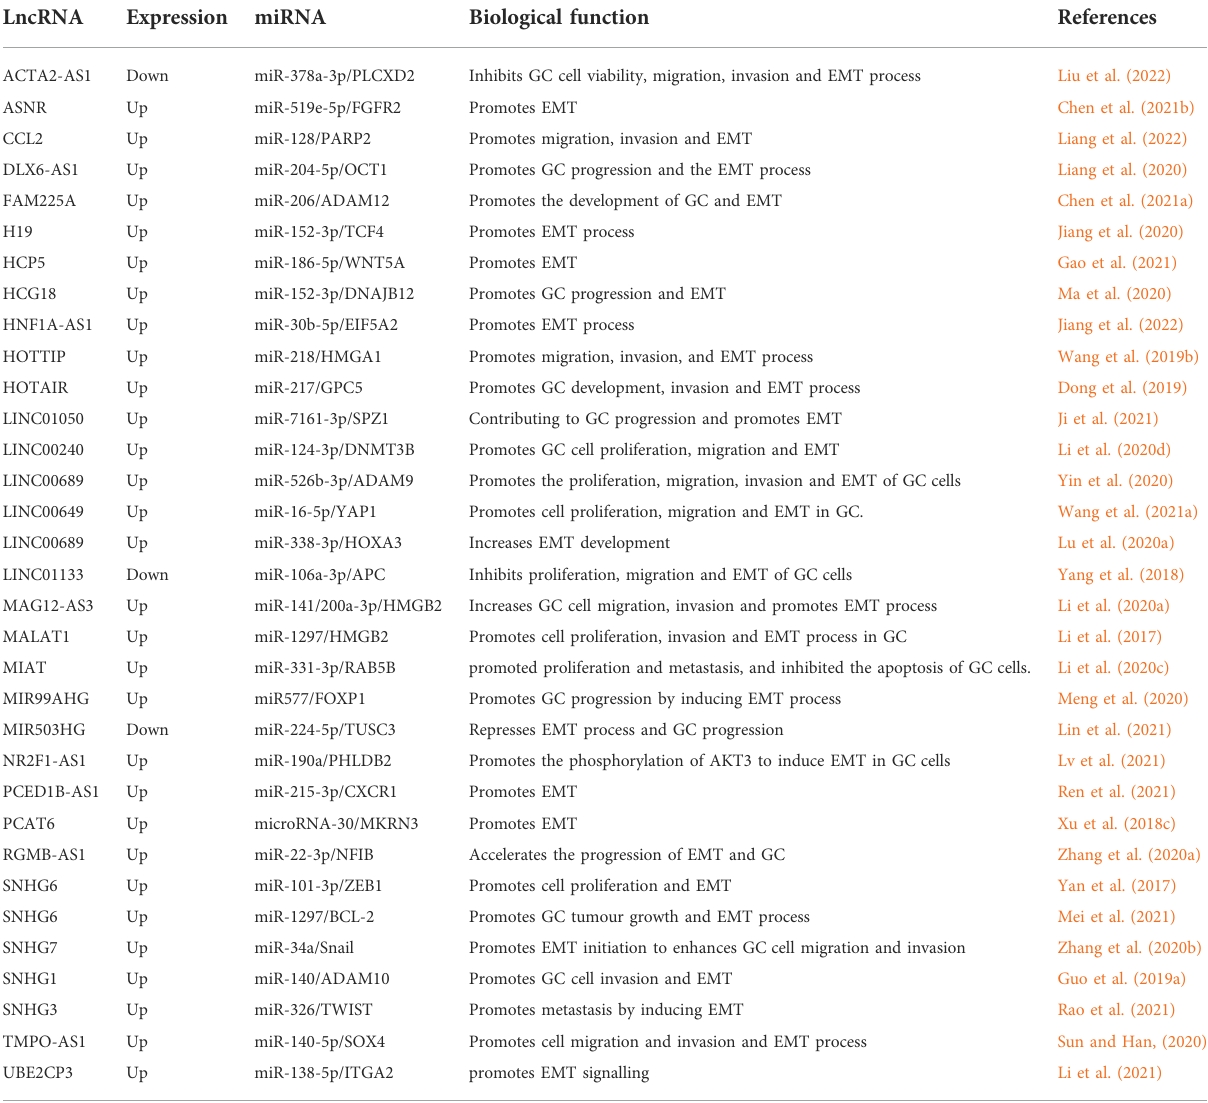
TABLE 3 LncRNAs and their associated miRNAs in the regulation of EMT-induced metastasis in GC. LncRNA